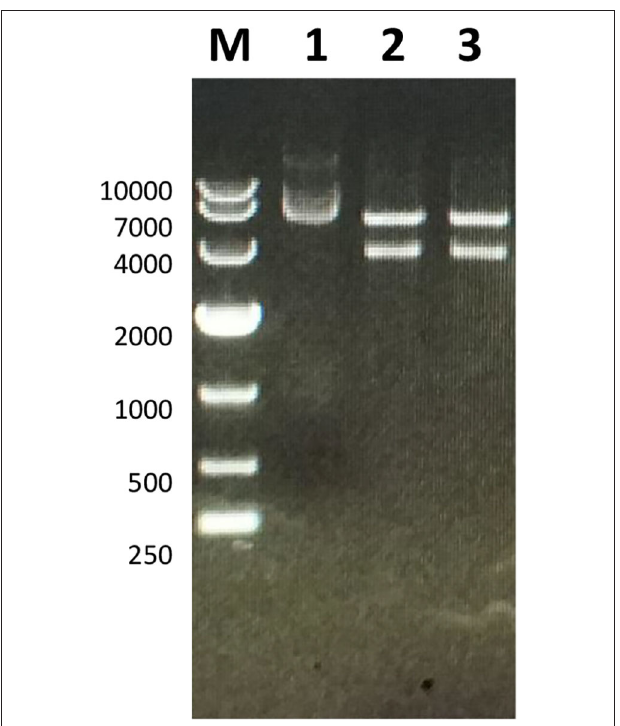
FIGURE 2 | Electropherogram of Twinstrep-SUMO-hu LwCas13a plasmid. M: DL 10,000 DNA Marker; 1: Plasmid extracted from E. coli ; 2,3: Double-digested